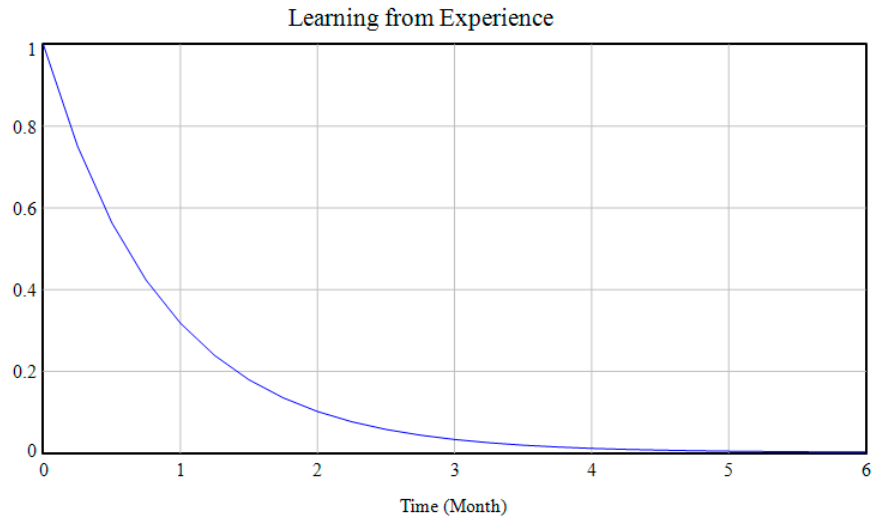
Figure 17. Simulation result of ‘learning from experience’.